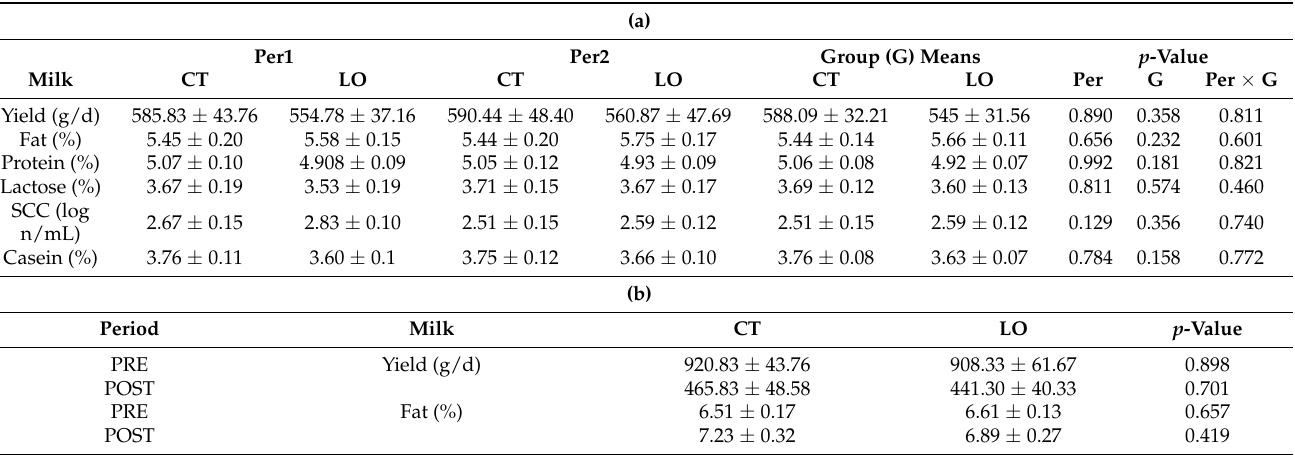
Table 3. ( a ) . Milk yield and milk composition in Sarda dairy ewes non-supplemented (CT; n = 24) and supplemented with bypass linseed oil (LO; n = 24) in dairy Sarda ewes non-supplemented (CT) and supplemented with bypass linseed oil (LO; from Per1 to Per2). ( b ) . Milk yield and milk